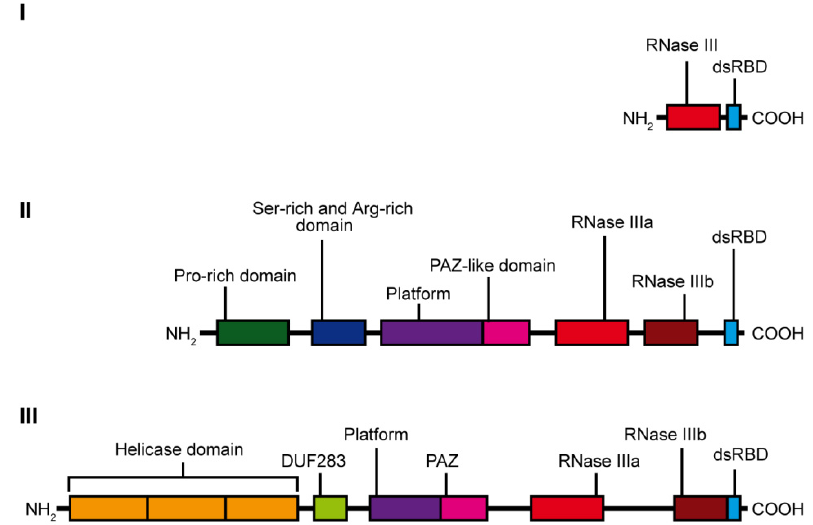
Figure 1. Scheme showing the domain organization of the individual classes of the RNase III family enzymes: class I—represented by E. coli ribonuclease III, class II—represented by human Drosha ribonuclease and class III—represented by hDicer ribonuclease.